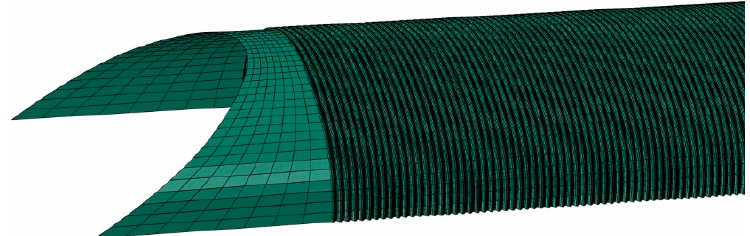
Figure 21. Steel shell in the numerical model: corrugated sheets in the center, equivalent shell close to the bridge ends.